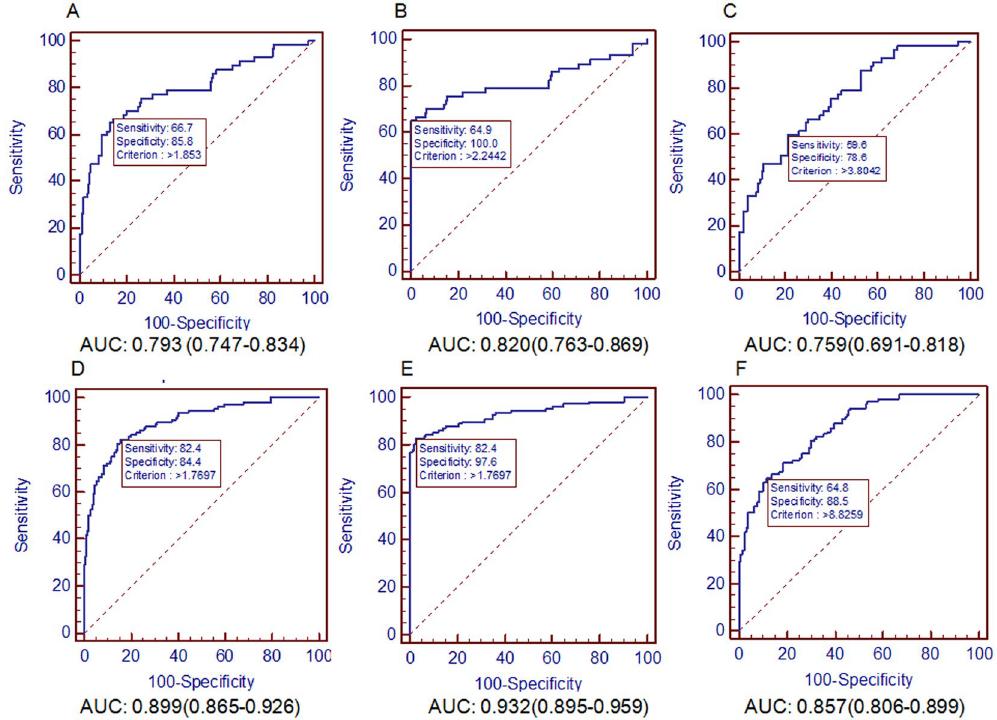
Figure 4. ROC analysis of APAR for HCC diagnosis in different BCLC stages. AUC of APAR for predicting HCC in ( A ) HCC versus non-cancer control in the early BCLC stages, ( B ) HCC versus healthy in the early BCLC stages, ( C ) HCC versus CHB in the early BCLC stages; ( D ) HCC versus non-cancer control in the late BCLC stages, ( E ) HCC versus healthy in the late BCLC stages, ( F ) HCC versus CHB in the late BCLC